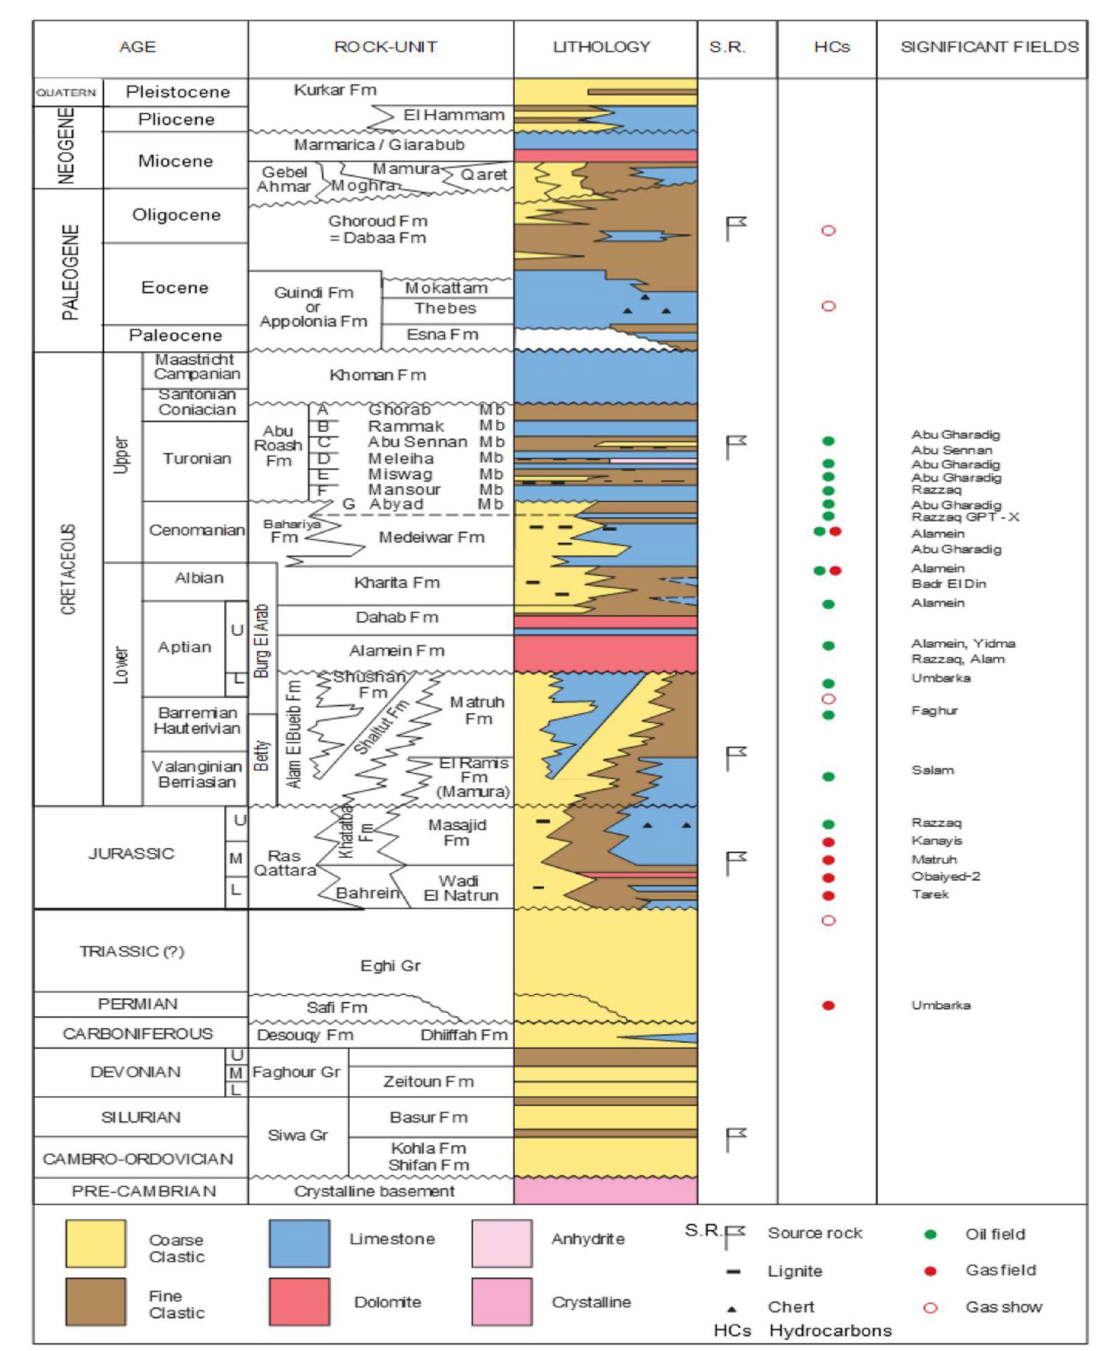
Fig. 3 General lithostratigraphic column of the North Western Desert Modified by Abdelmaksoud et al. (2019) after Schlumberger